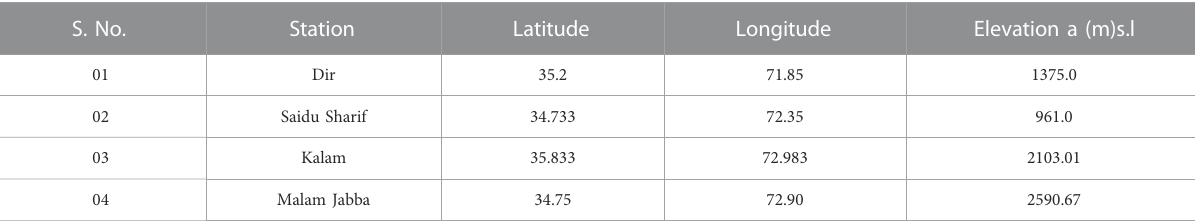
TABLE 1 Details of weather stations used in study. S. No.